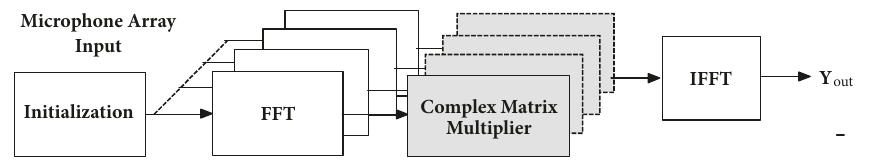
Figure 2: Dataflow of the main operations.